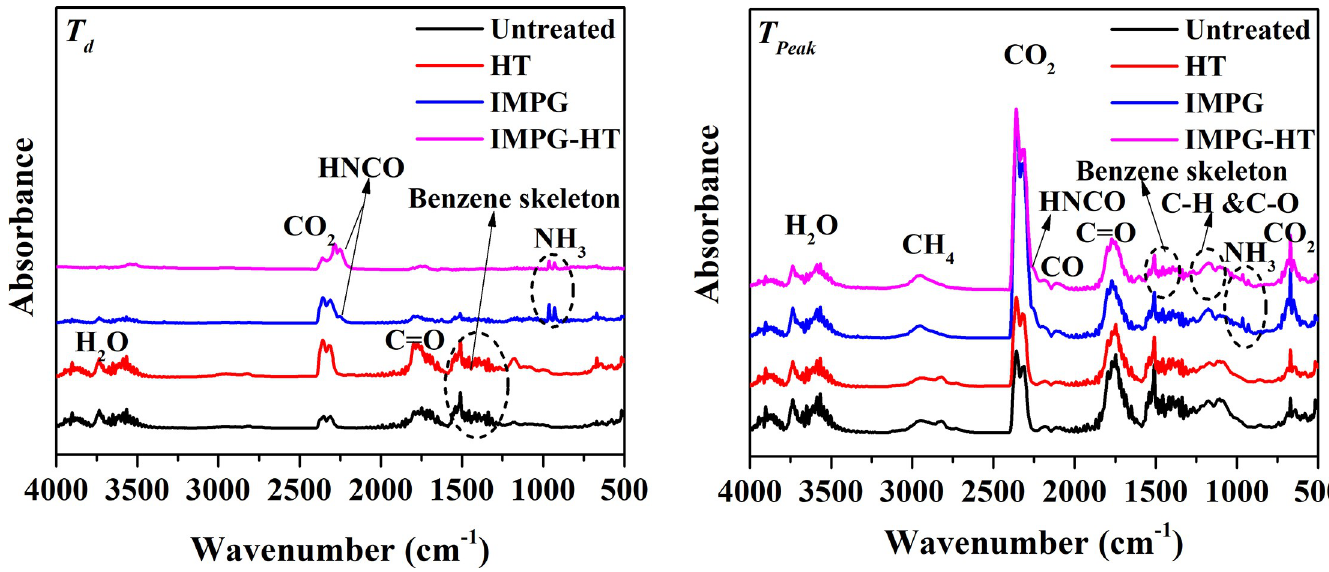
Fig 8. FTIR spectra of the pyrolysis gaseous products. (a) FTIR spectra of the pyrolysis gaseous products at T the pyrolysis gaseous products at T peak with a heating rate of 20˚C min -1